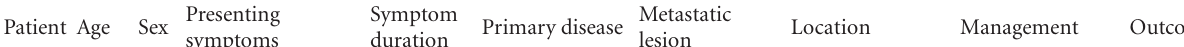
Table 1: Clinical, endocrine, and radiological features of 6 patients with metastatic tumors of the sellar/parasellar region. Patient